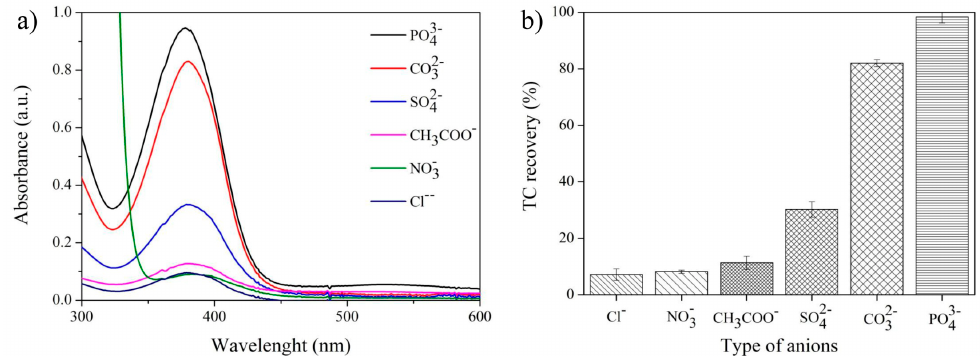
Figure 7. (a) UV-vis absorption spectra of TC and (b) the recovery efficiency after recovery of TC with various anions.